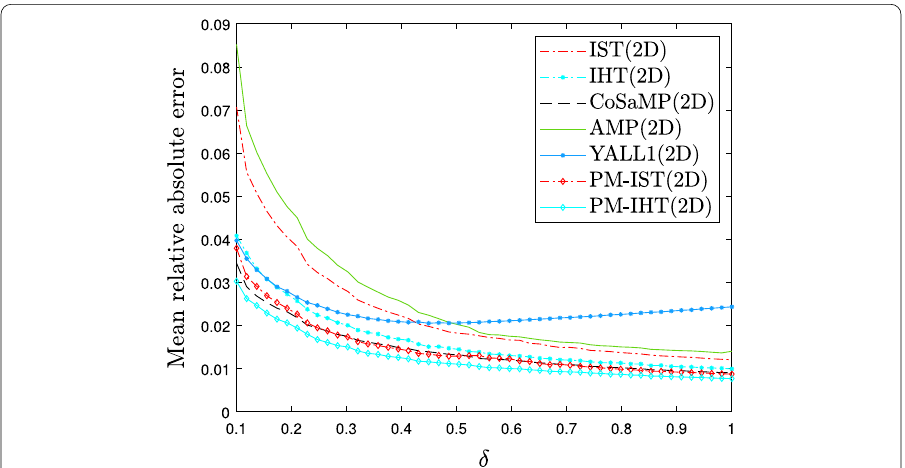
Fig. 7 Mean relative absolute error of 2D algorithms vs. compression ratio